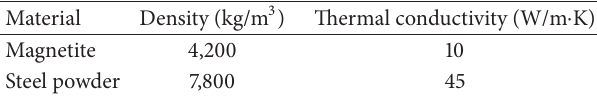
Table 6: Analysis condition for equivalent thermal